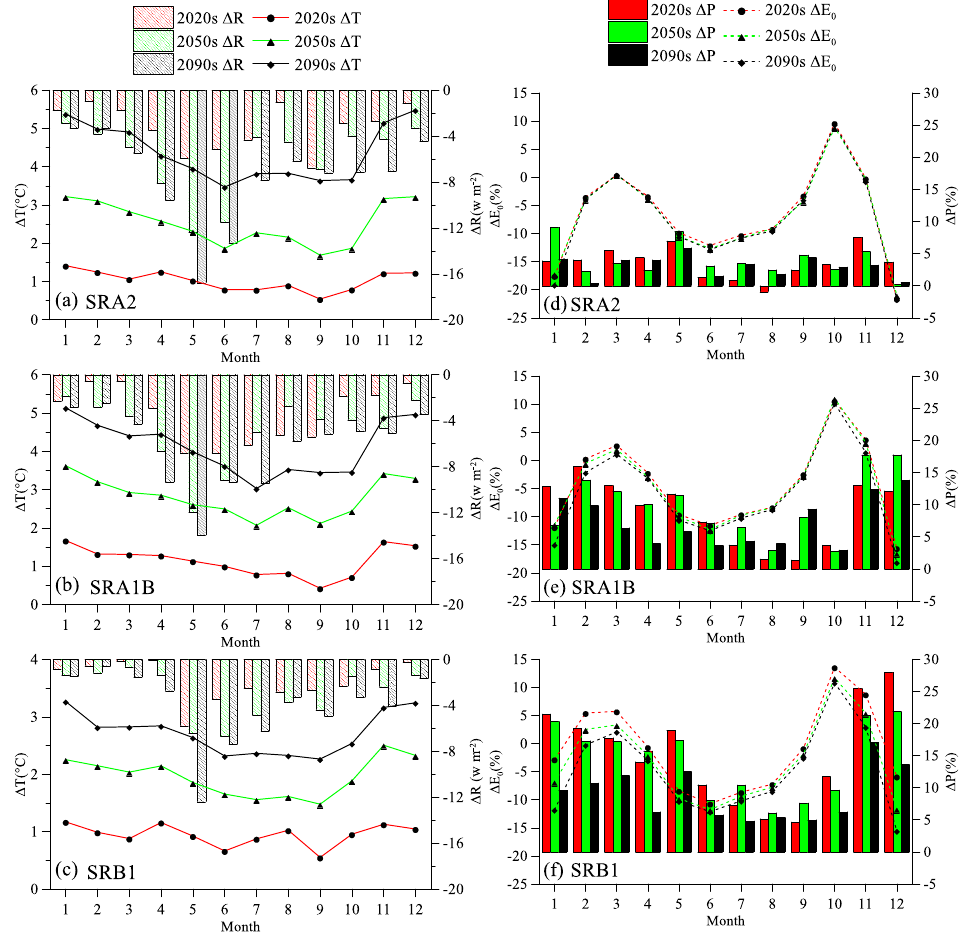
Figure 8. Projected climatic elements of the three periods. Table 3. Calibrated